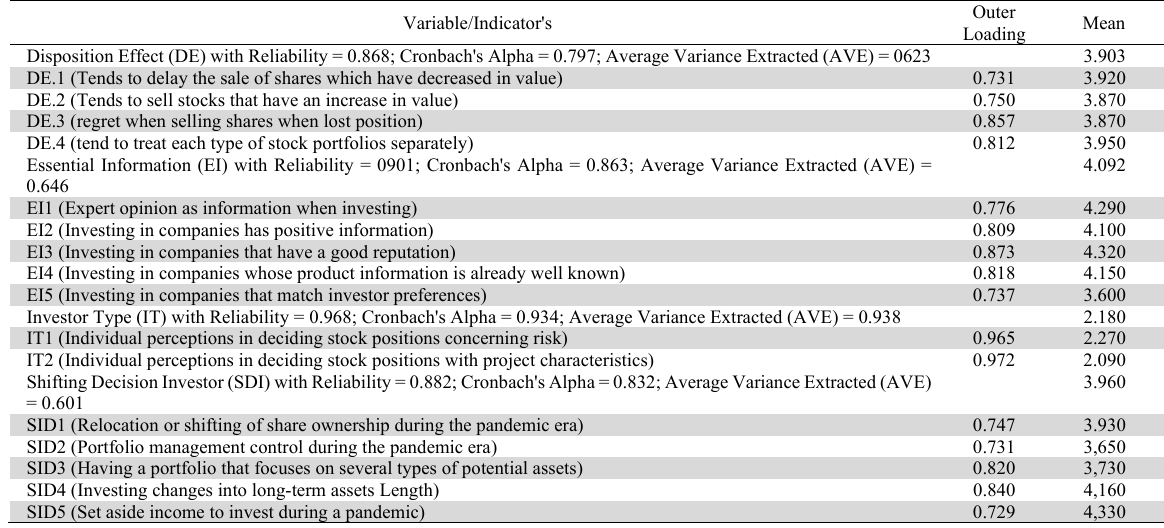
The results of factor loadings